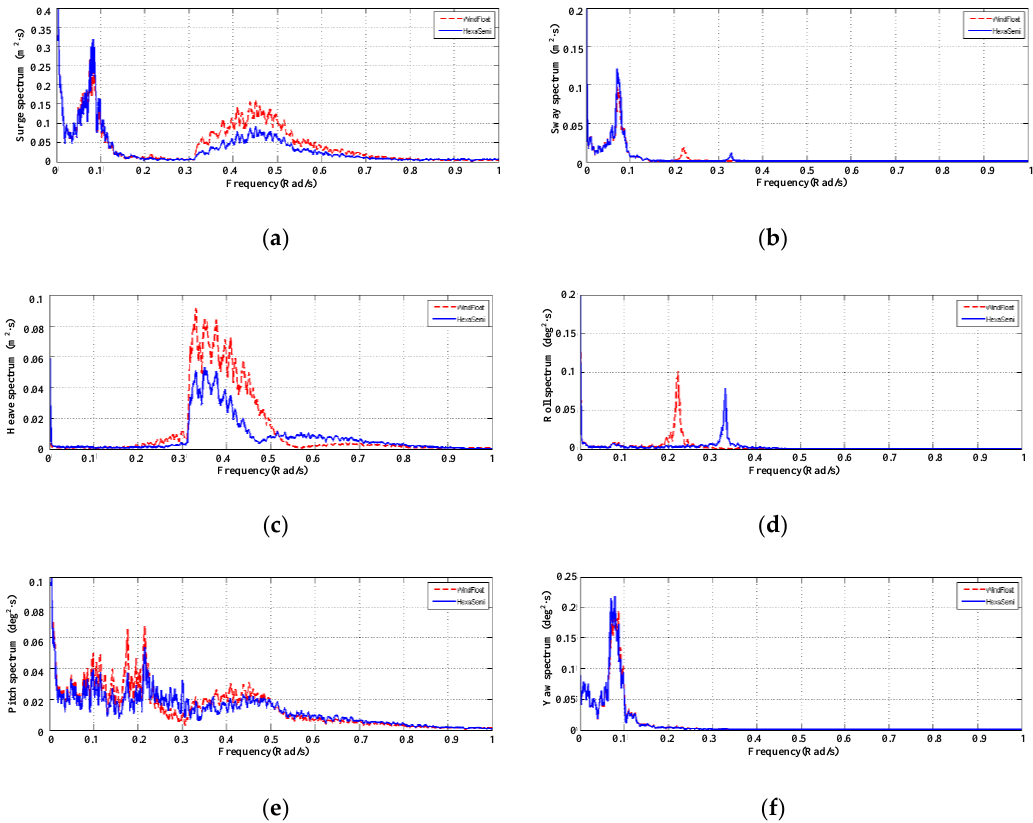
Figure 12. 6-DOFs motion spectrum under the operational condition: ( a ) surge, ( b ) sway, ( c ) heave, ( d ) roll, ( e ) pitch, ( f ) yaw.